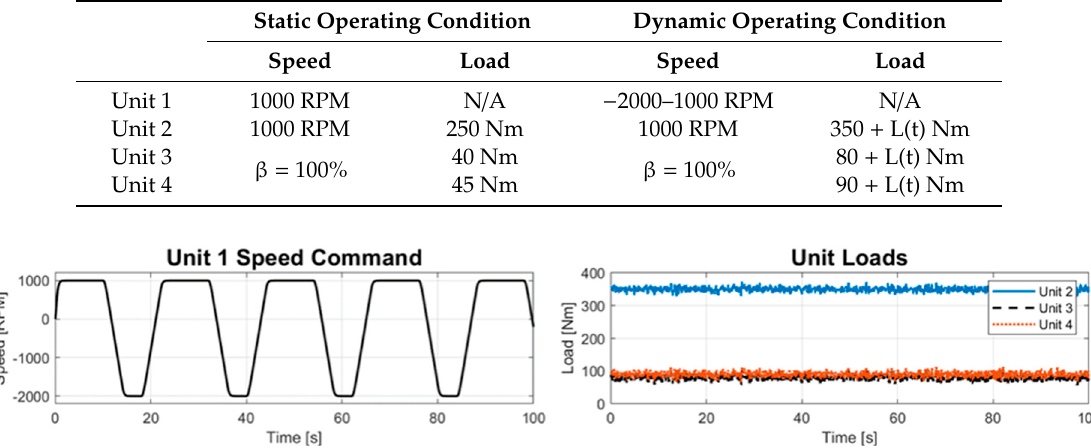
Figure 10. Dynamic operating condition simulation inputs.